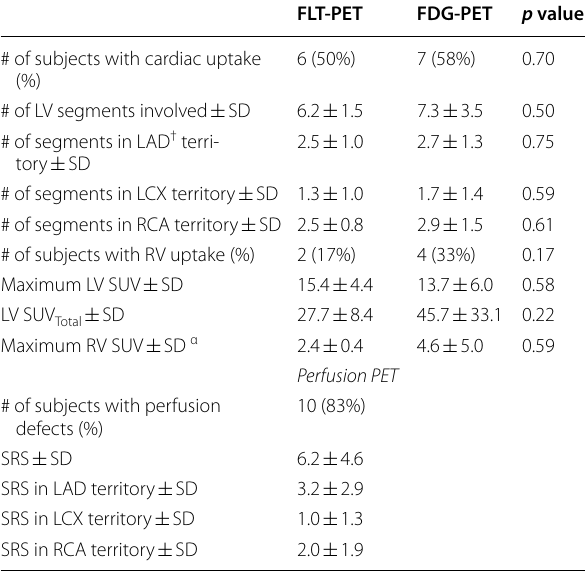
Fig. 7 FLT‑PET study in a subject with neurosarcoidosis